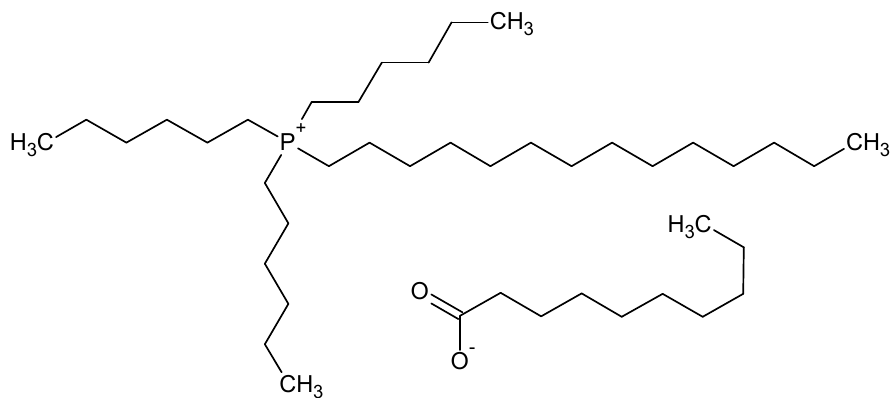
Figure 1. Chemical structure of trihexyl(tetradecyl)phosphonium decanoate (IL-D).